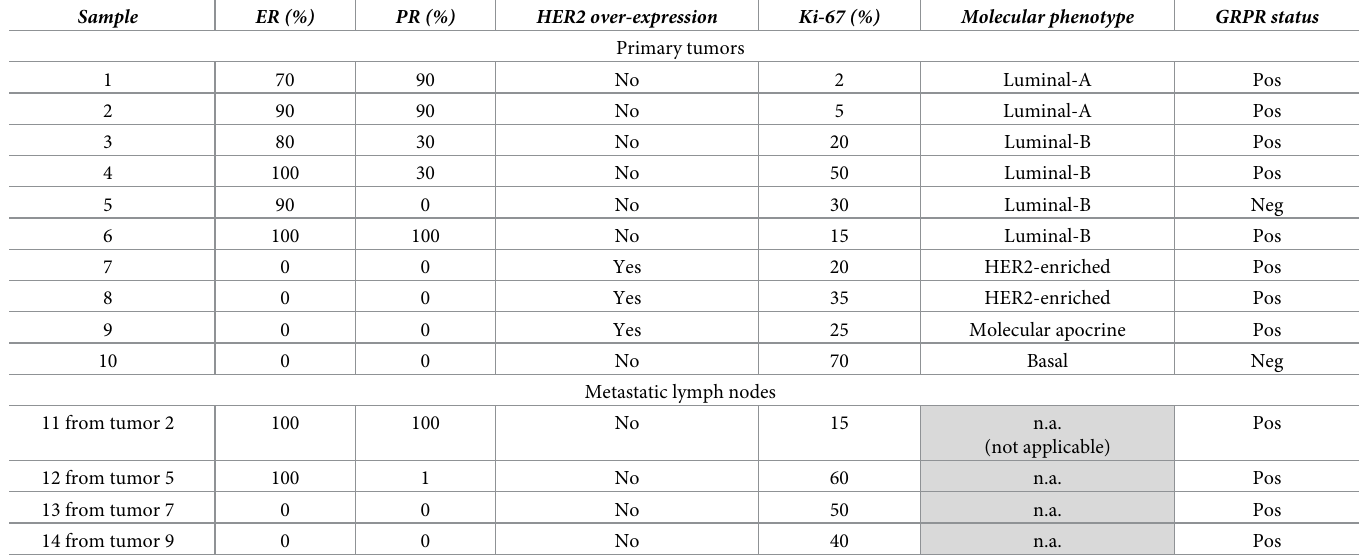
Table 1. Estrogen receptor (ER), progestin receptor (PR) expression, HER2 status, Ki-67 expression, molecular phenotypes and Gastrin-Releasing Peptide Receptor (GRP-R) expression in our series of samples.